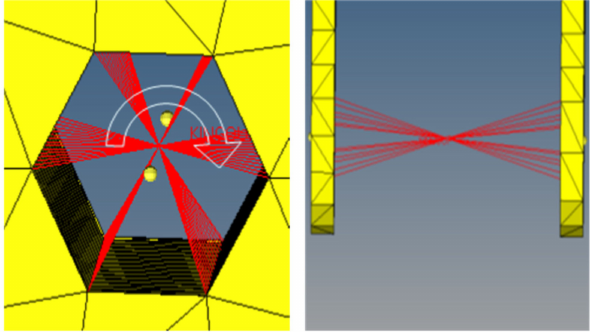
Figure 6. The constraint modeling for the pivot in the FEA model.